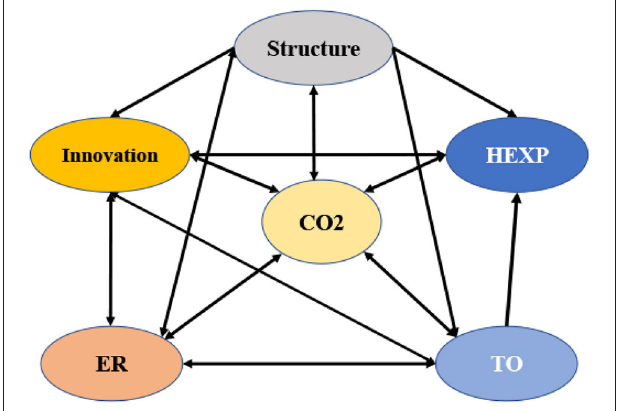
FIGURE 3 | Pair-wise panel causality tests.